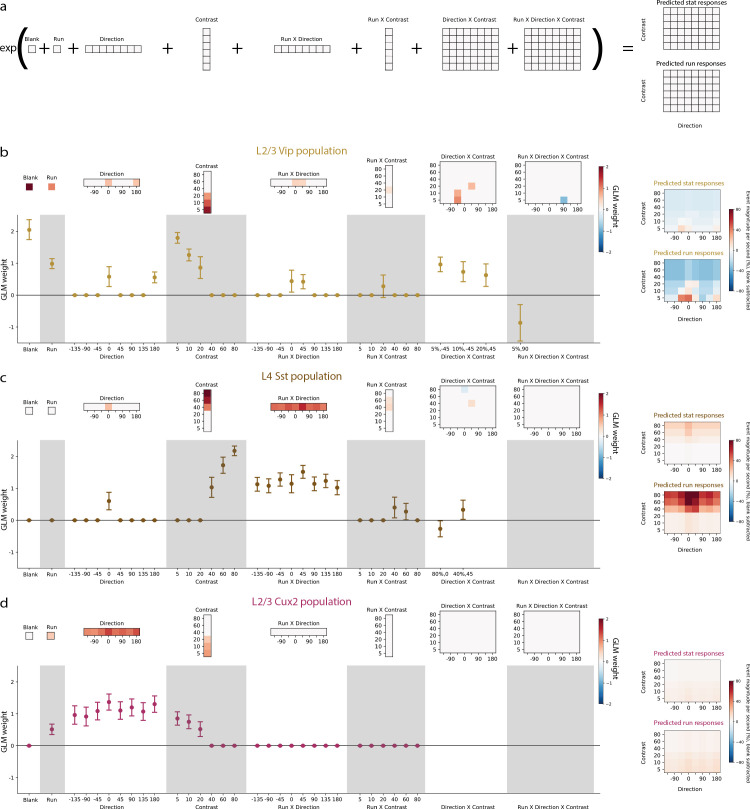
Generalized Linear Models reveal the contribution of stimulus direction, stimulus contrast, locomotion, and the interactions between these terms, to the activity of neuronal populations.(a) Schematic of the Poisson GLM consisting of a blank term, a binary run state term (1 for running, 0 for stationary), 8 direction terms, 6 contrast terms, 8 run x direction interaction terms, 6 run x contrast interaction terms, 48 direction x contrast interaction terms, and 48 run x direction x contrast interaction terms. The responses are predicted by summing these 126 terms and raising the sum to an exponential. (b) GLM results for the population of layer 2/3 VIP neurons recorded from Vip mice. Left: The model weights are shown as heatmaps (top) as well as means and 95% confidence intervals (bottom). Sparse weights were obtained using an L1-regularization penalty, resulting in the majority of weights to be zero. For direction x contrast and run x direction x contrast interaction terms, means and confidence intervals are only shown for terms with non-zero weights. Right: Predicted responses to stimulus conditions minus predicted blank response when the mouse is stationary (top) and running (bottom). (c) Same as b, but for the population of layer 4 SST neurons recorded from Sst mice. (d) Same as b, but for the population of layer 2/3 pyramidal neurons recorded from Cux2 mice.